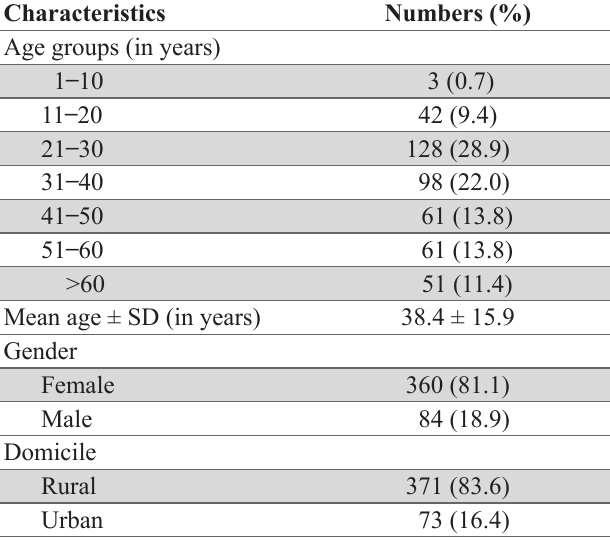
Table 1. Socio-demographic characteristics of patients (N = 444) Characteristics